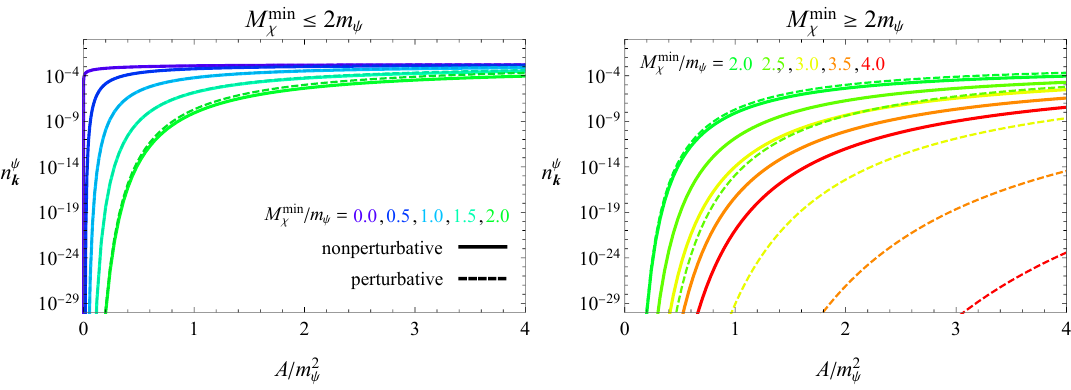
at k = 0 as a function of the parameter k q = m 2 + ζφ 2 ( t prod ) . χ χ